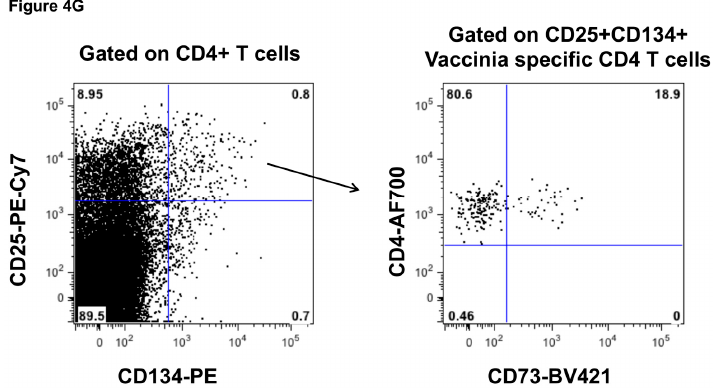
Figure 4. Proliferation of CD73+ CD45RO+ memory CD4+ T cells in vitro. ( A ) Representative flow plots of proliferating CD25 high Cell Trace Violet dim (CTV dim ) CD73+ CD45RO+ memory CD4+ T cells at day 7, in response to mitogen staphylo- coccal enterotoxin B (SEB), or recall antigens M. tuberculosis lysate (MTB) or human simplex virus lysate (HSV) for n = 2 healthy adult controls, C014 and C004. ( B ) Summary data of the difference in proliferation in response to the mitogen SEB of CD73+ CD45RO+ memory CD4+ T cells versus CD73-negative CD45RO+ memory CD4+ T cells. ( C ) Transcription and intracellular markers in CD73+ CD45RO+ memory CD4 T cells in peripheral blood from healthy donors. All flowplots were first gated on CD73+ CD45RO+ memory CD4+ T cells. Upper flowplots are from 3 healthy adult donors and show subsets of expression of T-bet and TCF-1. Lower flowplots are from donor IVPP23 and show subsets of cytotoxic molecules, granzymes A, K and B versus TCF-1. ( D ) Transcription and intracellular markers in CD73+ CD8+ T cells in peripheral blood from healthy donors. All flowplots were first gated on CD73+ CD8+ T cells. Upper flowplots are from 3 healthy adult donors and show subsets of expression of T-bet and TCF-1. Lower flowplots are from donor IVPP23 and IVPP44 and show subsets of cytotoxic molecules, granzymes A, K and B versus TCF-1. ( E ) Representative flow plots of intracellular cytokine production by CD73+ CD45RO+ memory CD4+ T cells, in response to mitogen staphylococcal enterotoxin B (SEB), or recall antigens human simplex virus lysate (HSV) or vaccinia virus lysate, for n = 2 healthy adult controls C004 and C021. ( F ) Representative flow plots of CD25+CD134+(OX40+) CD4+ T cells, at day 2, in response to recall antigens M. tuberculosis lysate (MTB) or human simplex virus lysate (HSV), showing that gated OX40+ CD4 T cells contained detectable CD73+ CD4+ T cells, for n = 2 healthy adult controls C004 and C014. ( G ) Representative flow plots of CD25+CD134+(OX40+) CD4 T cells, at day 2, in response to vaccinia virus lysate, showing that gated CD25+OX40+ CD4+ T cells contained detectable CD73+ CD4+ T cells, for healthy adult control C021, representative of 4 experiments.